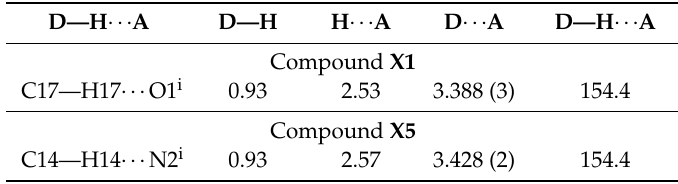
Table 2. Hydrogen-bond geometry (Å, ◦ ) of compounds X1 and X5